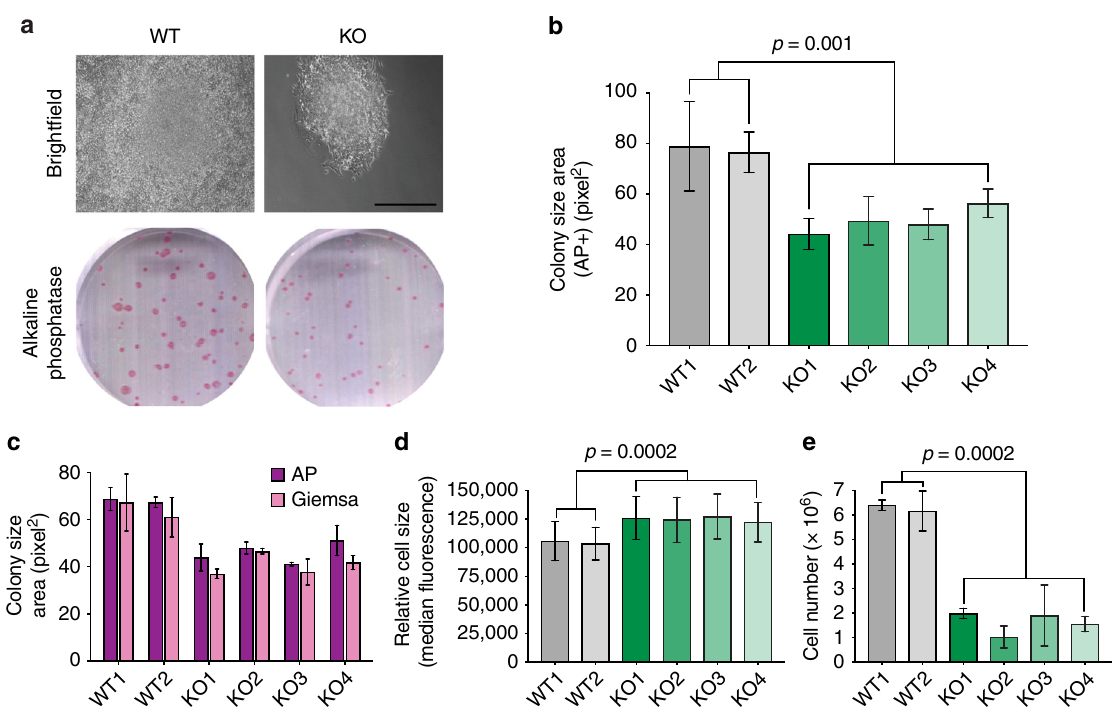
Fig. 1 Loss of E2F4 leads to defects in mouse ES cell growth. a Representative bright fi eld images (scale bar, 400 µ m) and alkaline phosphatase (AP) staining (wells from a 6-well plate are shown) of wild-type (WT) and E2F4KO (KO) colonies one week after plating single cells ( n > 10 assays per genotype). b Quanti fi cation of the size of AP + colonies (unpaired t -test; n = 3 biological replicates per clone). c Comparison of the area of AP staining (undifferentiated cells) versus Giemsa staining (all cells) in an independent set of colonies ( n = 3 biological replicates per clone) (no signi fi cant differences). d Size of WT and E2F4KO individual cells as estimated by forward scatter in fl ow cytometric analysis (unpaired t -test; n = 2 biological replicates per clone). e Total number of cells per 10 cm dish one week after plating at low density (unpaired t -test; n = 3 biological replicates per clone). Data shown as the mean and standard error of the